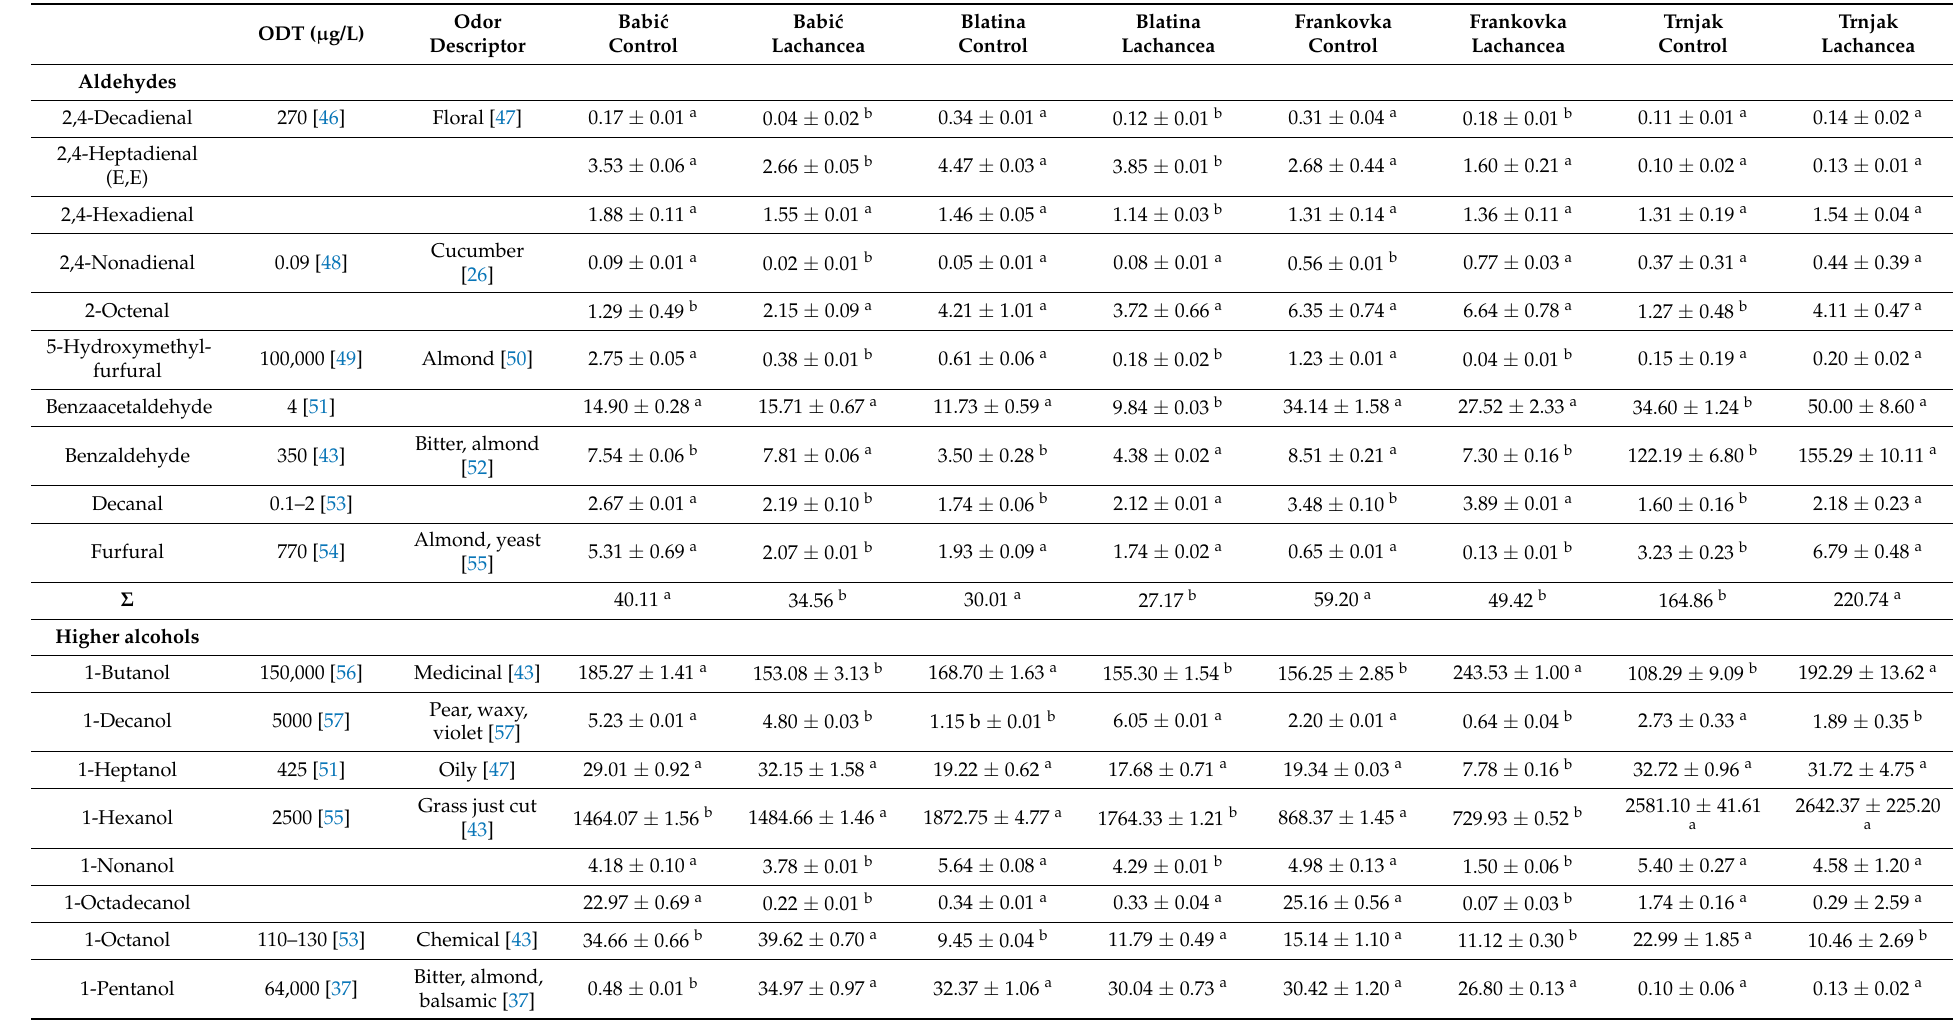
Table 2. Individual volatile compound concentrations ( µ g/L) of Blatina, Babi´c, Frankovka, and Trnjak red wines. Concentrations expressed as mean ± standard deviation ( n = 3). Means with different superscript letters, for each variety separately, in the same row differ significantly ( p ≤